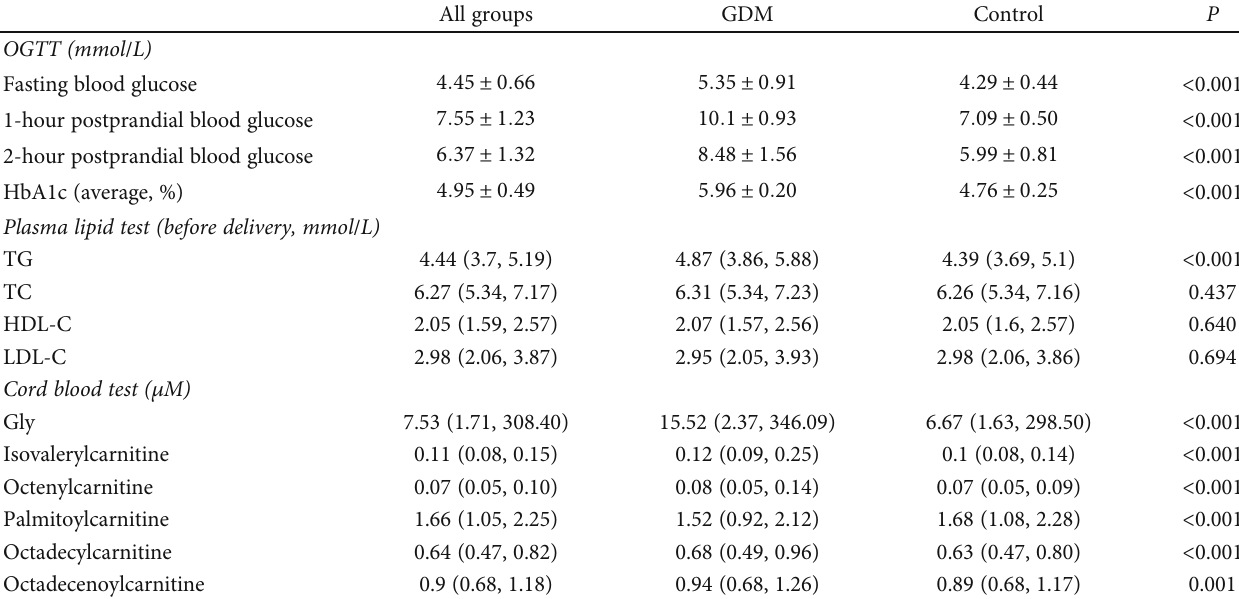
Table 2: Blood tests on pregnant women and neonates. All groups